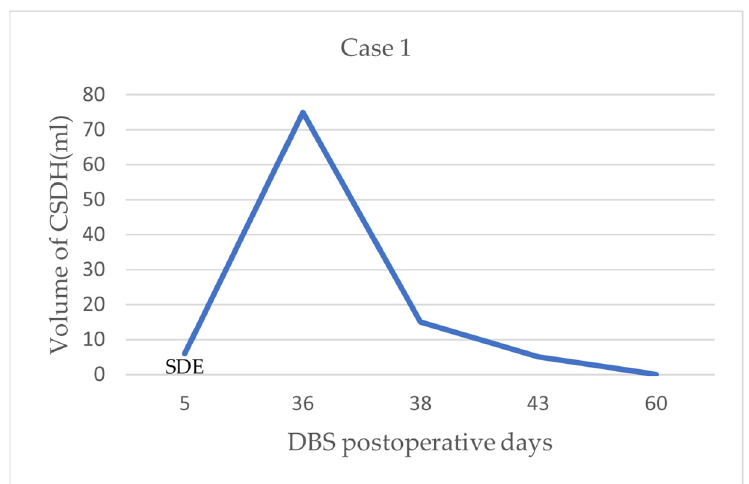
Figure 2. The change in CSDH volume in pre- and post-operative evacuation in case 1. At 5 day after DBS surgery, CT shows the volume of subdural effusion (SDE) in the right frontal lobe was 6 ml; at 36 days after DBS surgery, the volume of right chronic subdural hematoma is 75 mL; at 2 days after drainage, residual hematomas volume was 15 mL; until day 60, the hematoma was completely